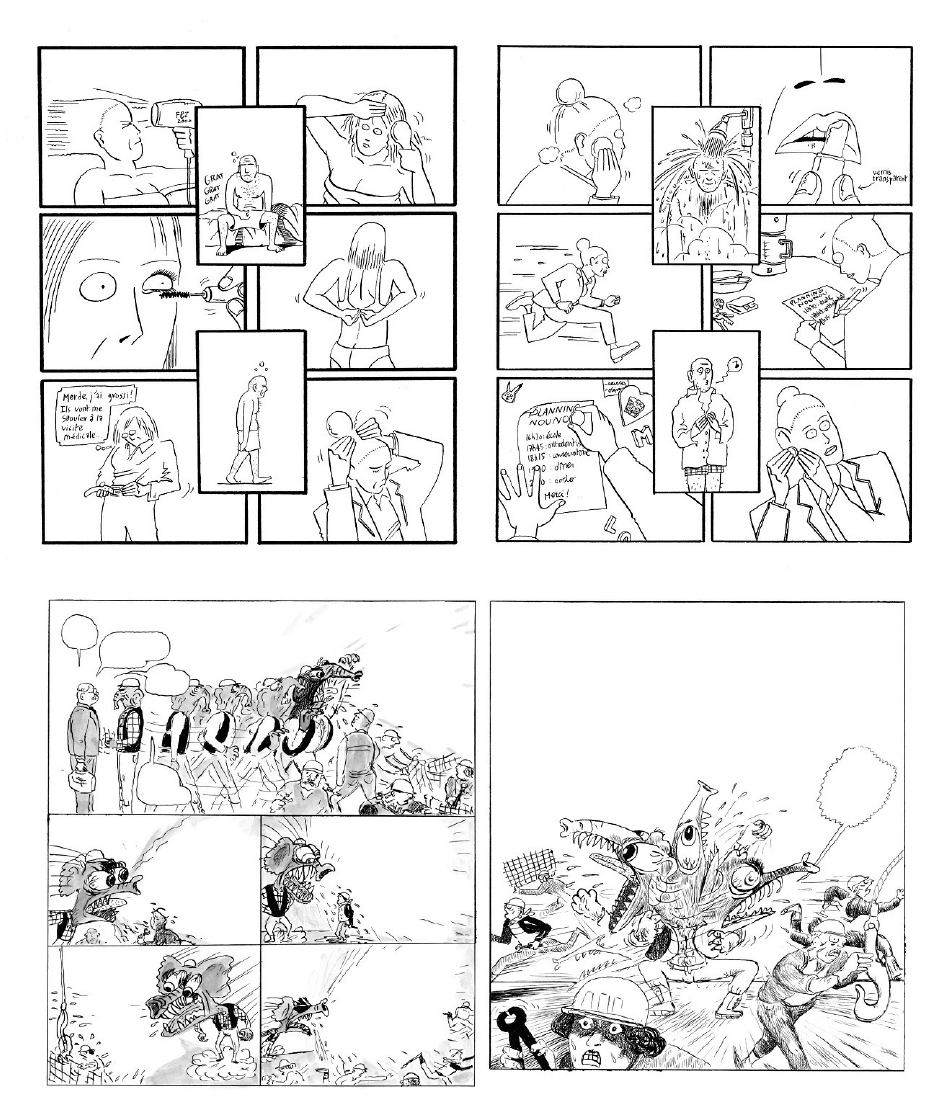
Figure 4: Turbulences, Lambert/Virot ©CASTERMAN (above); Chantier interdit au public, Jounin/Braud ©CASTERMAN